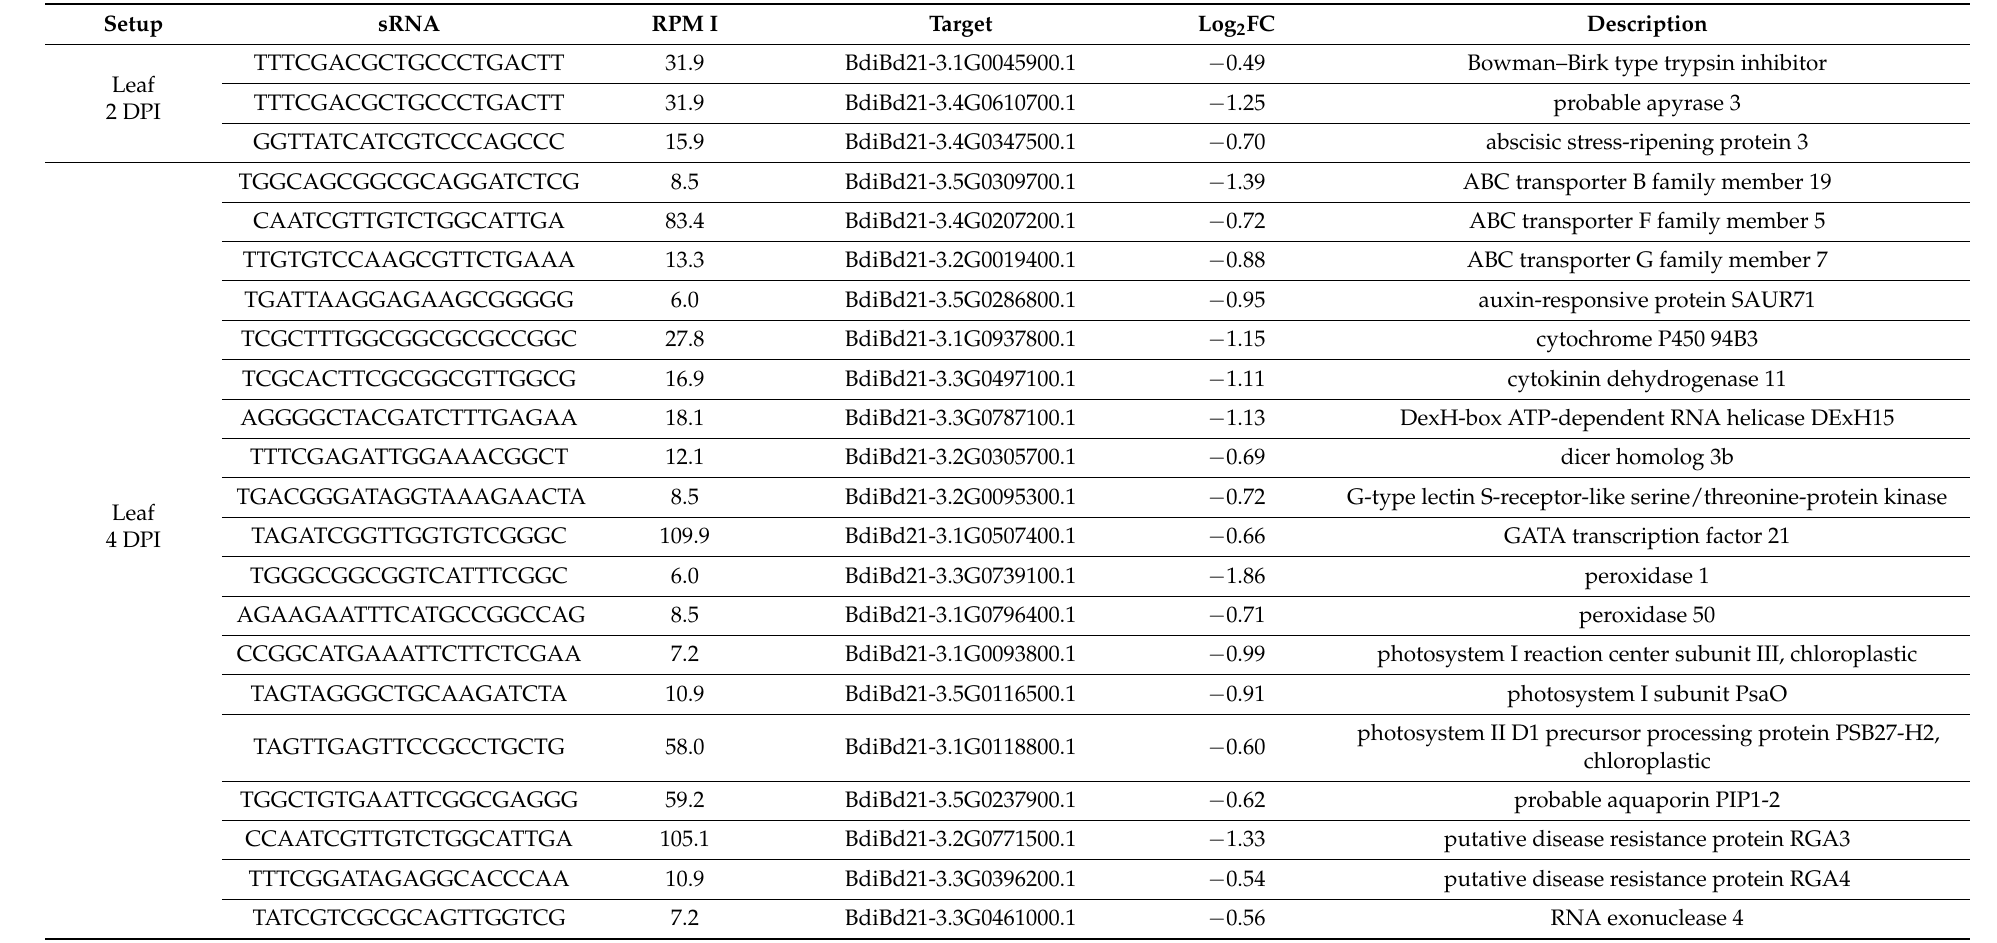
Table 6. Selection of Mo sRNA/Bd mRNA duplexes from different leaf and roots